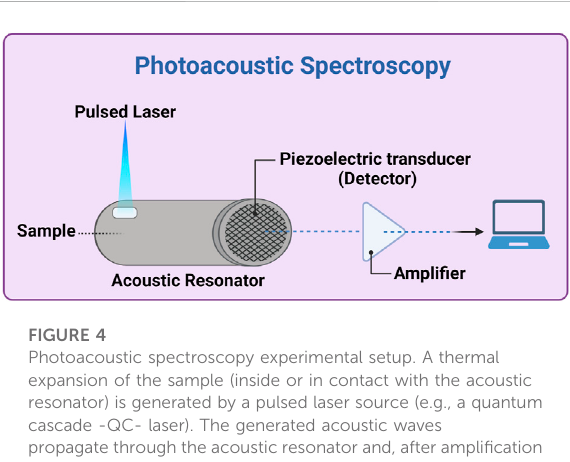
FIGURE 4 Photoacoustic spectroscopy experimental setup. A thermal expansion of the sample (inside or in contact with the acoustic resonator) is generated by a pulsed laser source (e.g., a quantum cascade -QC- laser). The generated acoustic waves propagate through the acoustic resonator and, after ampli fi cation and possibly ADC (analogic-digital converter), is analyzed by a computer. Created with